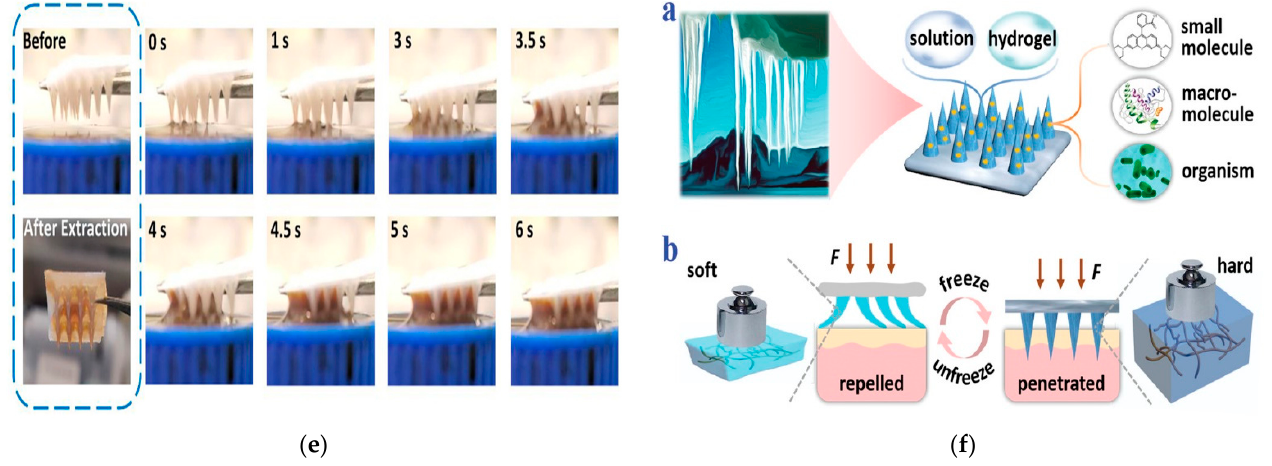
Figure 5. ( a ) Application of microneedles in cosmetics [158], a–d—Stereoscopic microscopic images of dissolving microneedles; e—SEM image of single dissolving microneedles; f—Magnified image of dissolving microneedle surface; ( b ) Application of microneedles in diagnostics and tumor therapy [143], ( c ) Microneedle application in the treatment of diseases [126], ( d ) Transdermal delivery of drugs using 3D-printed microneedle array [159], A—3D-printing showing i—fabrication process. ii—and CAD view of sample MNAs. B—Microscopic images of sample MNAs. C—SEM images of i-front view ii-top view of single hollow microneedle. D—Printing of microneedle arrays for the creation of rigid needles on a flexible base. E—The characterization of mechanical properties of microneedle islands. F—Microscopic view of microneedles array i-before and ii-after penetration into pig skin. G—Characterization of forces(insertion and withdrawal) of microneedles island applied to pig skin; ( e ) Biosensing applications of microneedles [156], ( f ) Application of microneedles in wound healing [160], a—Ice-formation-inspired microneedles made from soft materials (e.g., solution and hydrogels). b—Transition from softness to hardness achieved through